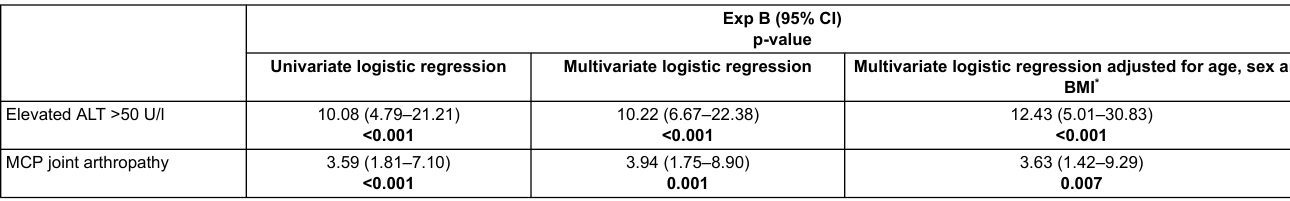
Table 3: Univariate and multiple logistic regression analysis comparing patients with substantial iron overload (serum ferritin levels >1000